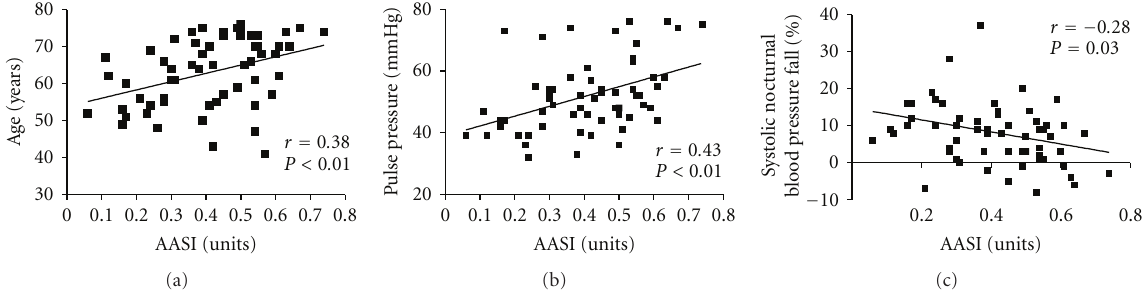
Figure 2: Plots of ambulatory arterial sti ff ness index on age (a), pulse pressure (b), and systolic nocturnal blood pressure fall (c).